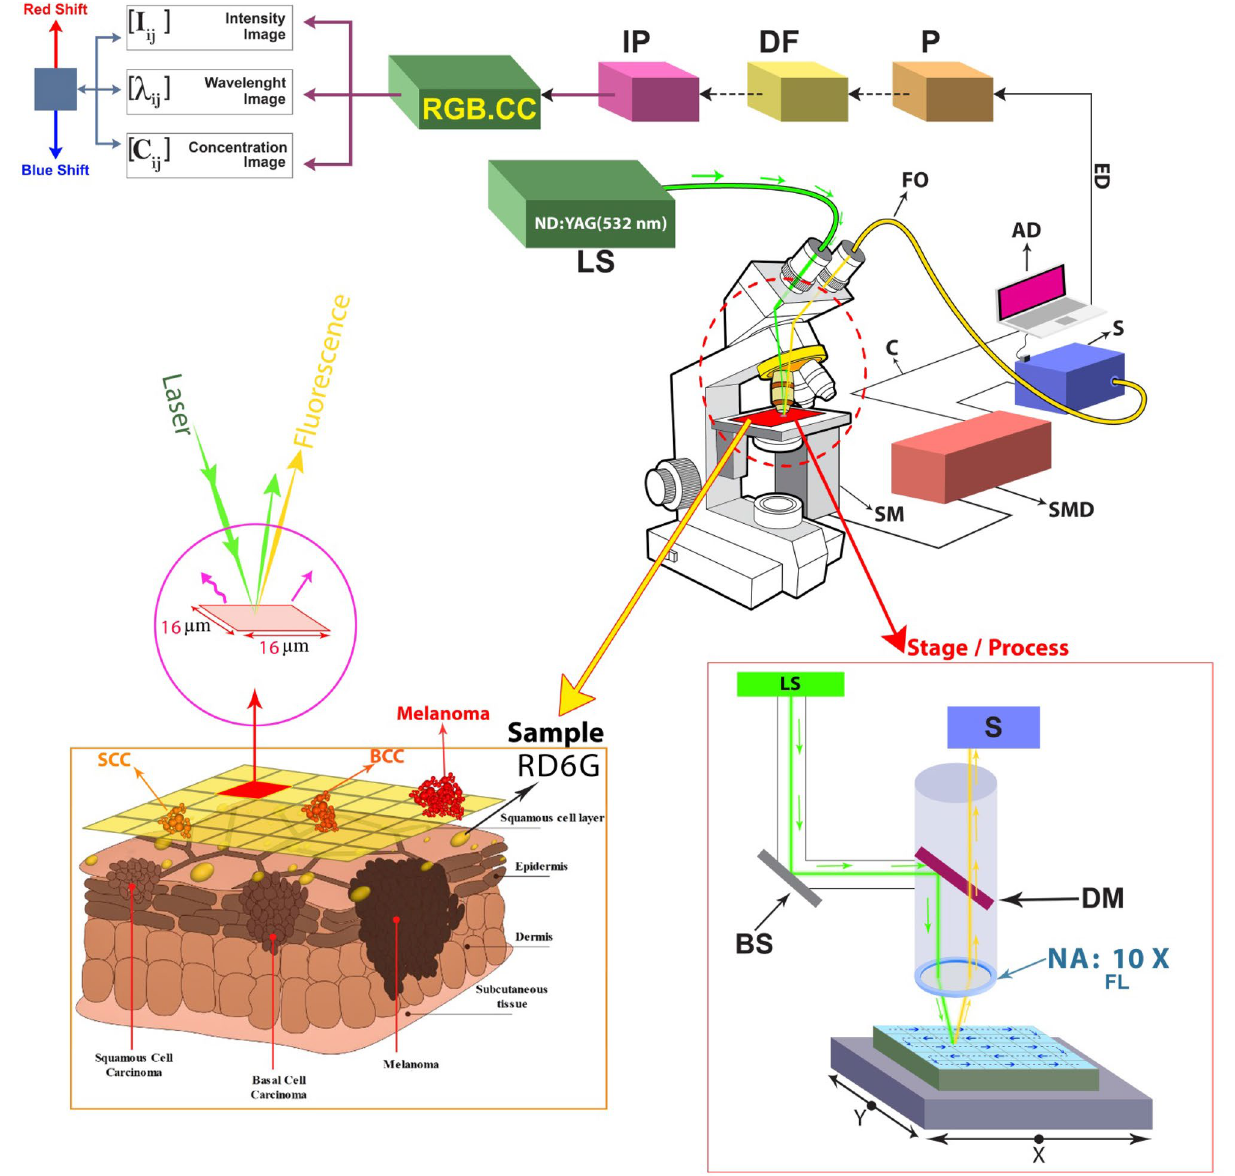
Figure 6. Schematic arrangement of SSFM and Rd6G concentration, including signal processing unit, filtering, and image processing unit, gives out three sets of fluorescence micrographs, i.e., signal intensity images, spectral micrographs, and Rd6G concentration mapping. ( IP image processing, DF digital filter, P processing, ED exporting data, AD analysis data, S spectrometer, SMD step motor drive, SM step motor, LS laser source, DM dichroic mirror, BS beam splitter, FL focus lens, FO fiber optic, C cable, RGB.CC RGB color